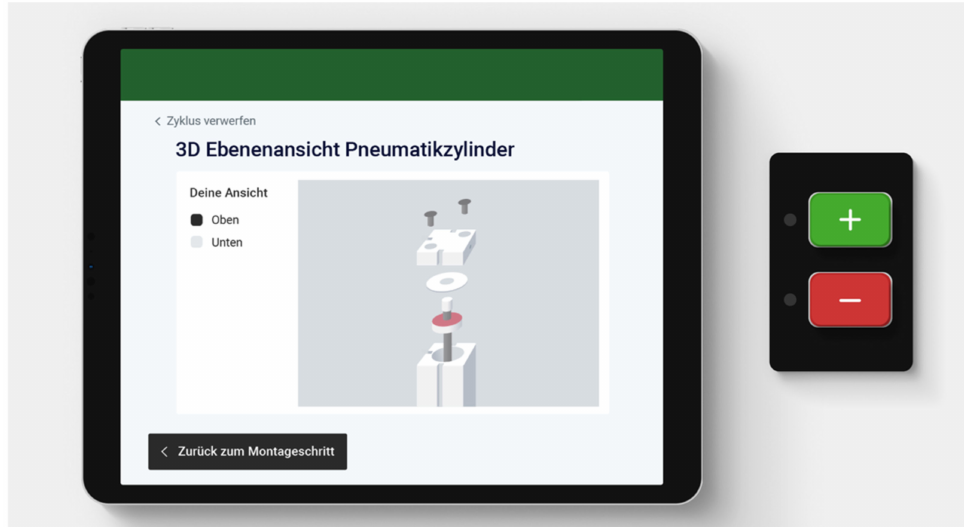
Figure 3. Screenshot of the test setup. In the centre, there is a screen of the prototype of the worker guidance system (WGS) placed on an animated tablet. To the right of the tablet there is a virtual keyboard with a green plus button and a red minus